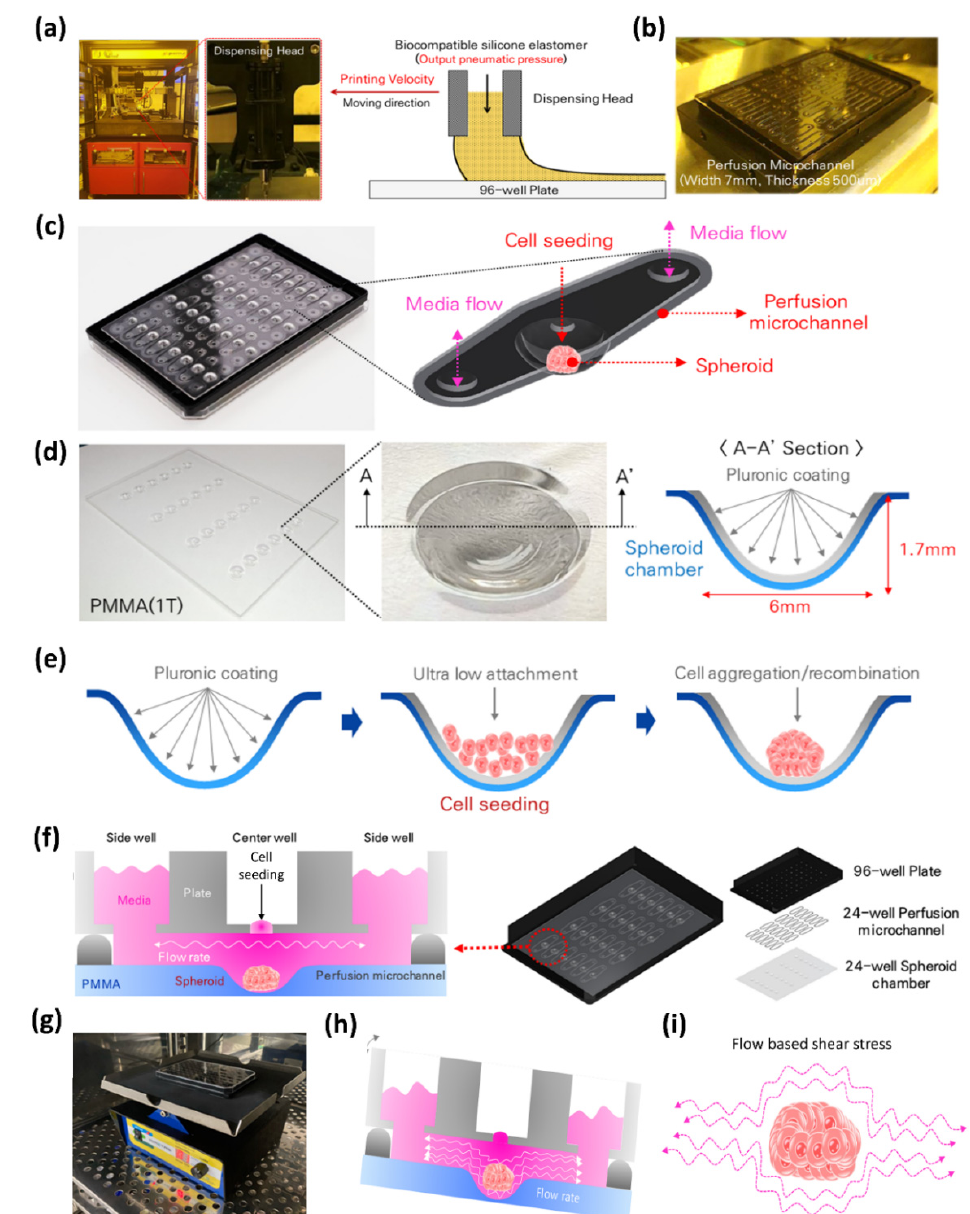
Figure 1. Plate fabrication and schematics of spheroid culture. ( a ) In-house build ink-jet printer for printing silicone to establish microfluidic channel across the array of 3 wells. ( b ) Printed microchan- nels for media perfusion. ( c ) Expanded view of microchannel. ( d ) PMMA layer with 24 well and spheroid well dimension. ( e ) Schematic of Pluronic127 coating, cell seeding, and spheroid formation. ( f ) Schematics of 3-well array for spheroid culture. ( g ) Mimetas™ rocker for dynamic spheroid culture. ( h ) Schematic of fluid flow in dynamic conditions. ( i ) Schematic of media perfusion inducing shear